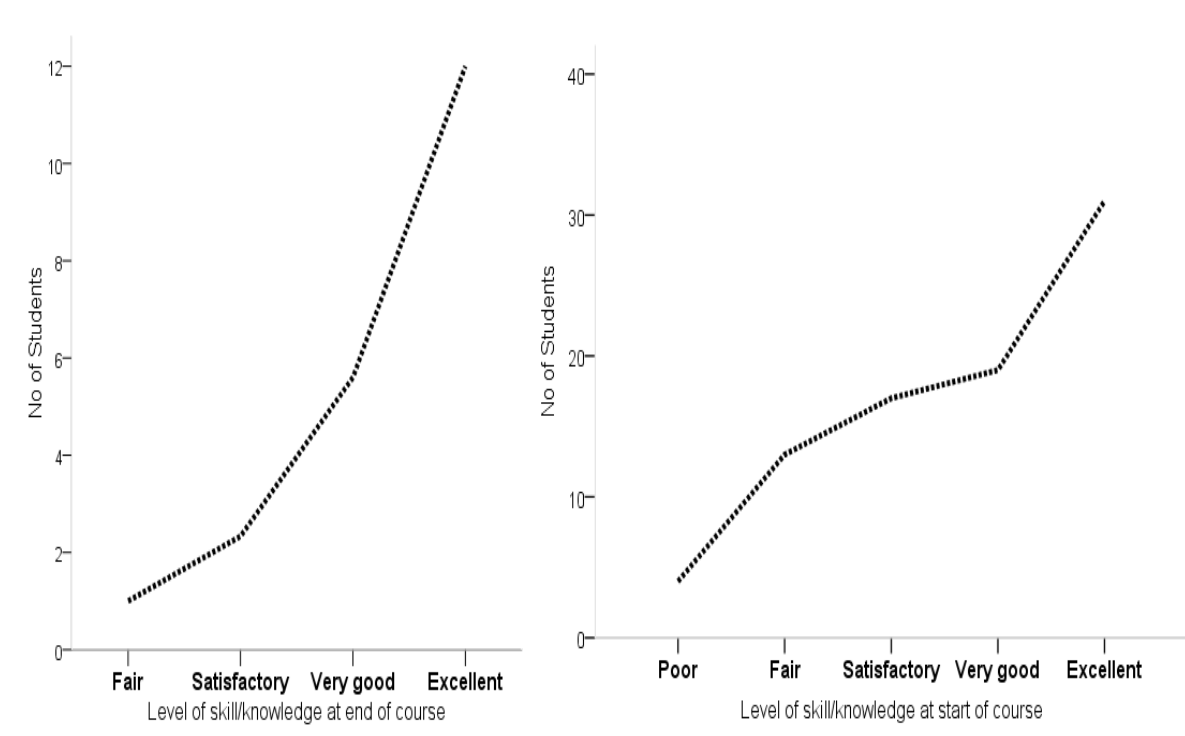
Figure 3. Levels of skill and knowledge before and after the course. Table 2. Personal development achieved through the course programme. Median (Muscle Functionality) Variable Beginning of Class End of Class